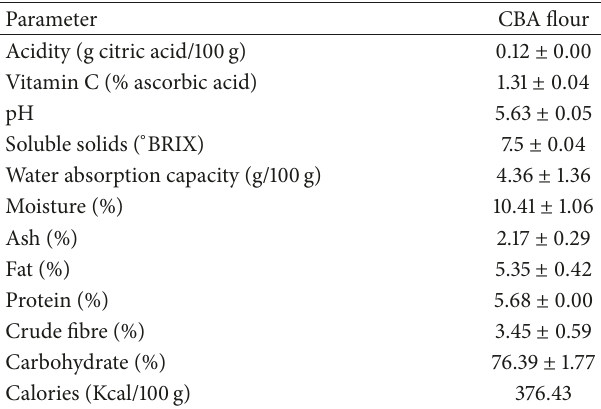
Table 2: Characteristics of CBA flour.